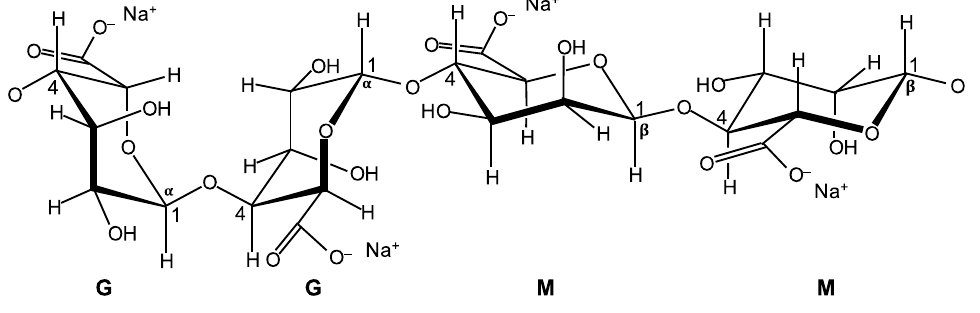
Figure 3. Chemical structure of sodium alginate (SA)-modified from [48].